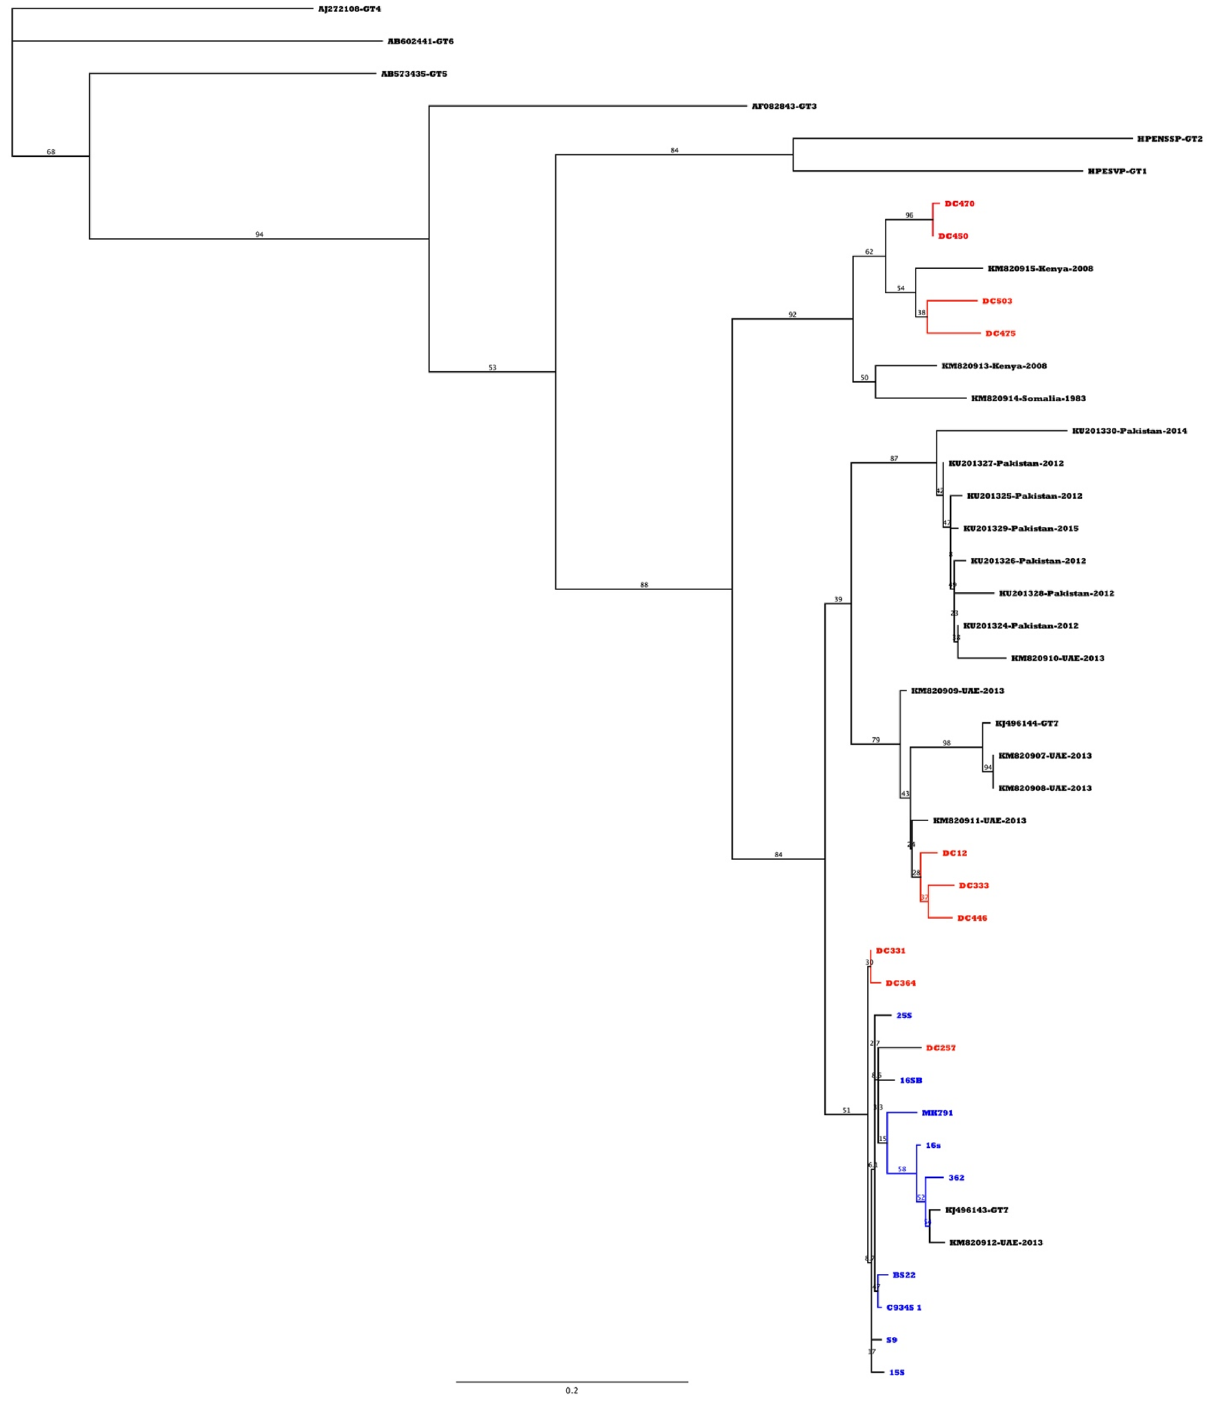
Figure 1. Phylogenetic tree for the RdRp gene of DcHEV Red-colored sequences represent domestic camels while blue colored sequences represent imported sequences. Phylogenetic tree was constructed using Maximum Likelihood method with 1000 bootstrap replicates using Geneious prime software (version